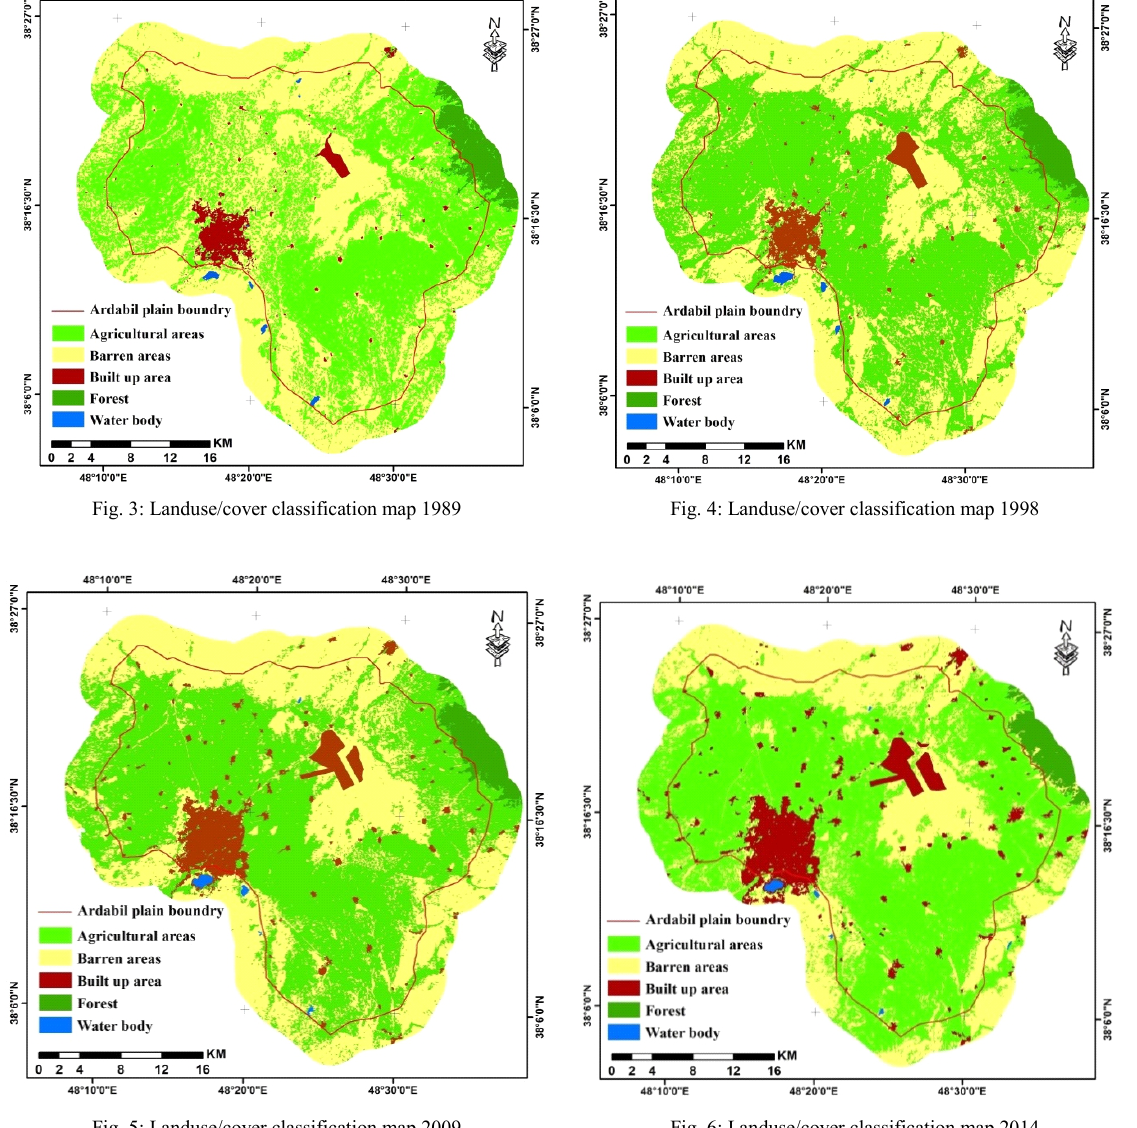
Fig. 6: Landuse/cover classification map 2014Fig. 5: Landuse/cover classification map